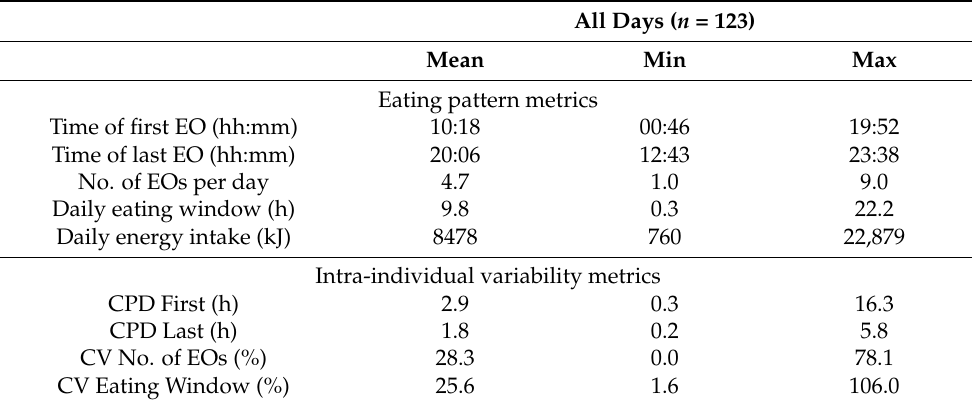
Table 3. Mean and range of eating pattern and intra-individual variability